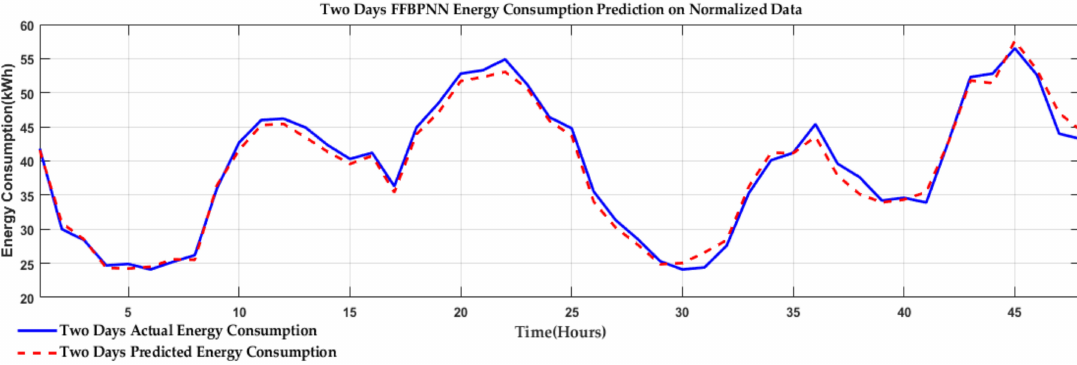
Figure 14. Two days of hourly energy consumption prediction using FFBPNN on normalized data.